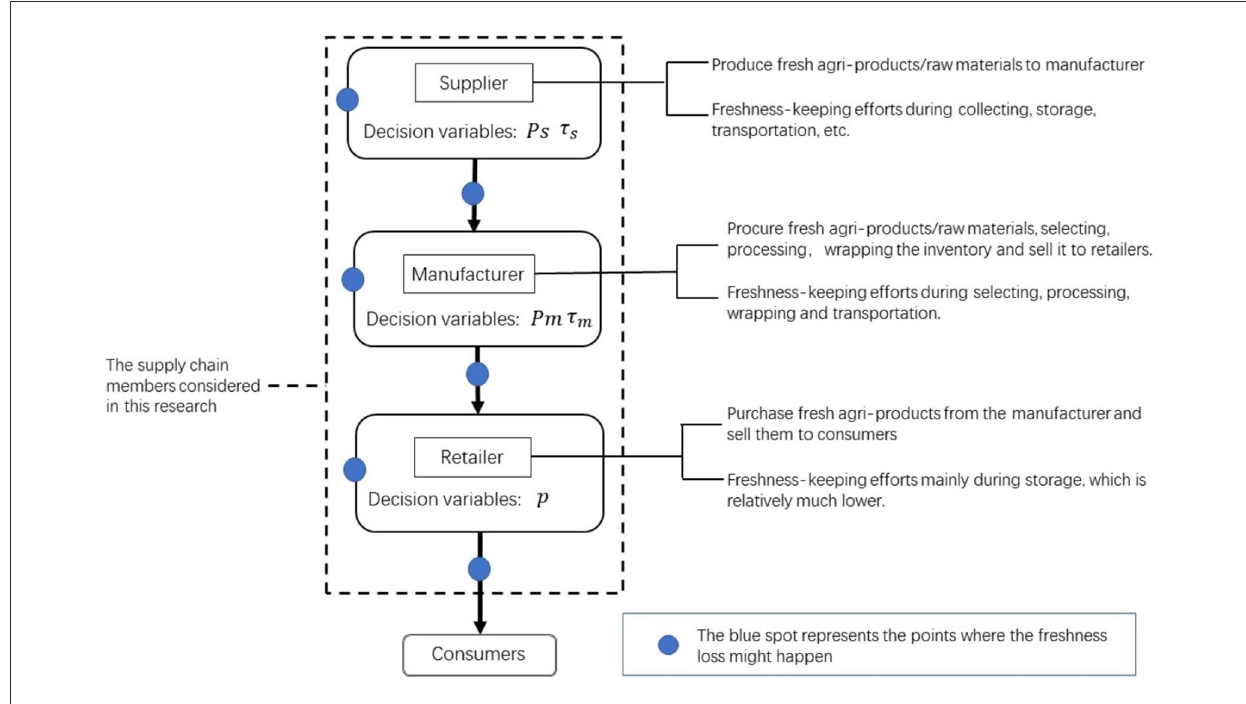
FIGURE1 Three-echelon fresh agriproduct supply chain.